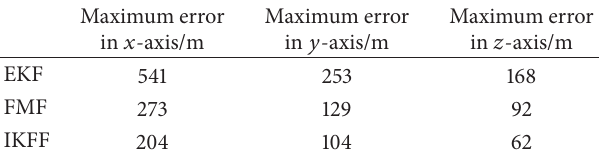
Table 2: The maximum AOD error of 𝐿 1 using different methods.